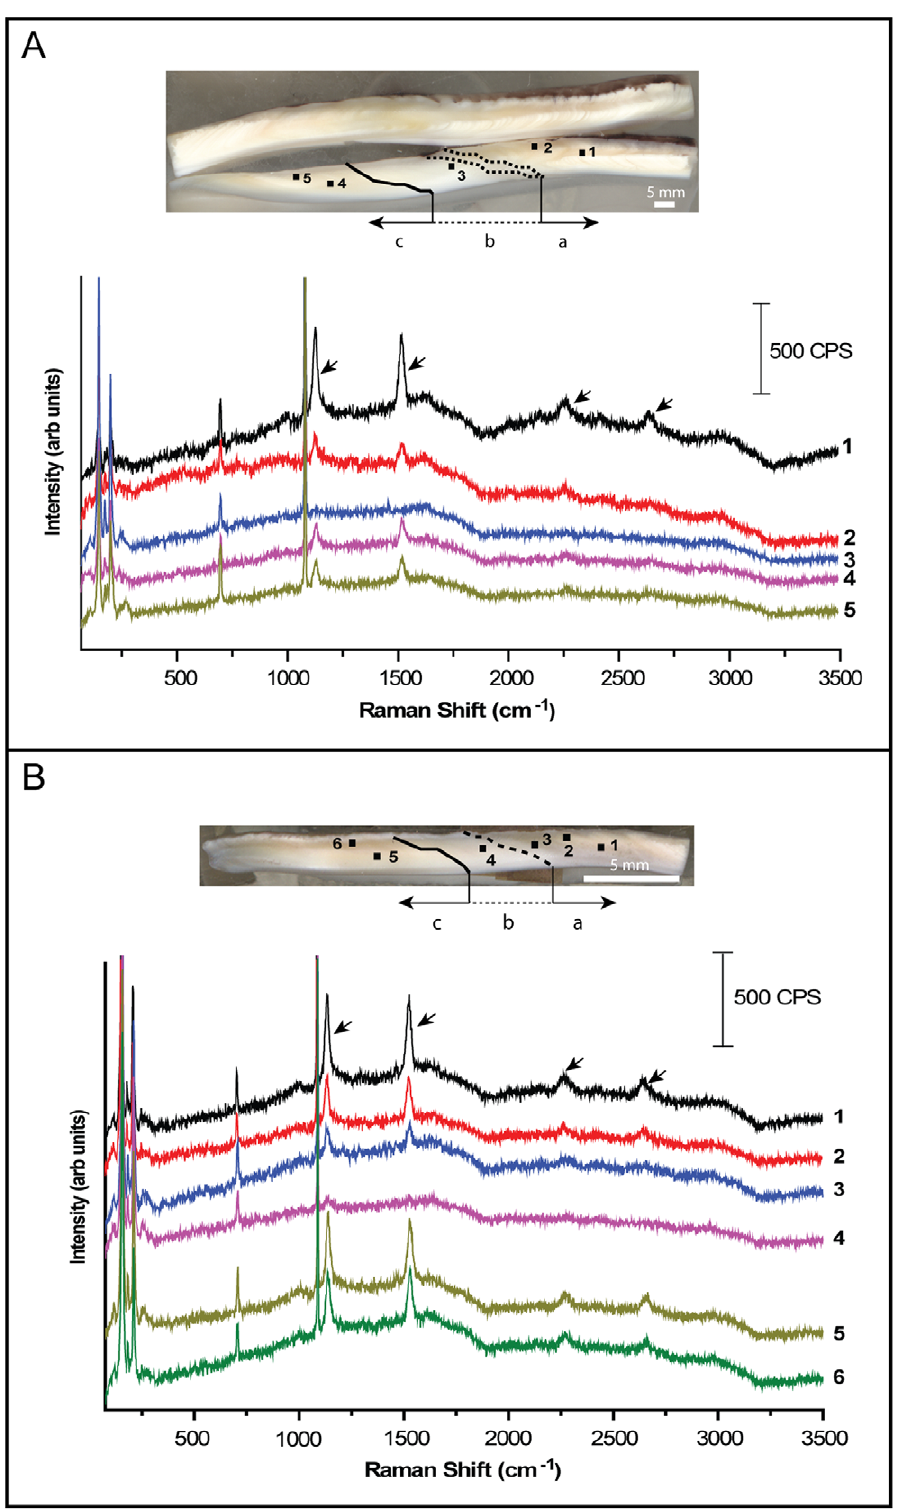
Figure 2. Insitu Raman spectroscopy data. Specimens 2TP4-3 (A) and 2TP4-4 (B) showing shell regions precipitated during (a), around the scar (b), and after (c) the 1982–1983 El Nin˜o event. Top image showing the shell with individual measurements with the shell scar (dashed lines) as a reference, and the bottom image with the corresponding Raman shift peaks. Peaks [arrows] at 1135 cm 2 1 and 1523 cm 2 1 , due to ( n 2 ) C-C single bonds and ( n 1 ) C=C double bonds respectively, and the corresponding overtone bands at 2270 cm 2 1 and 2645 cm 2 1 , disappear at the shell regions coincident with the maximum SST anomaly until normal biomineralization conditions resume after El Nin˜o event.